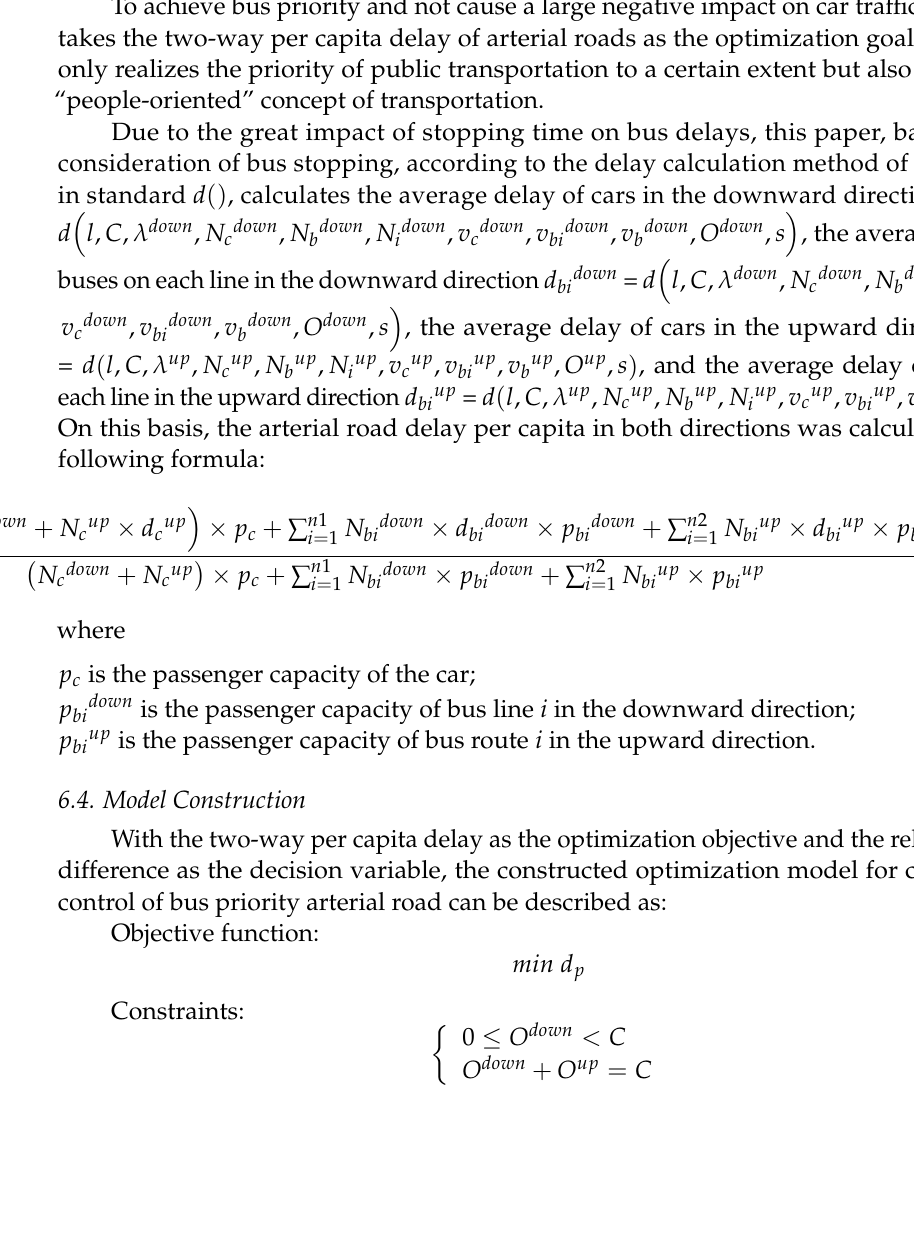
Figure 11. Change in average delay for each stopping time in the upstream direction.